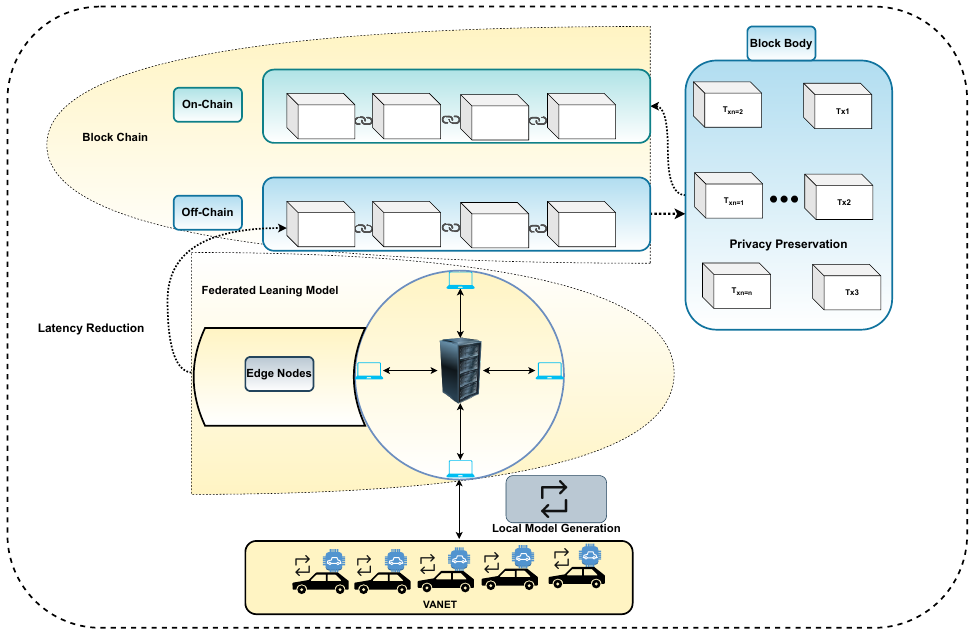
Figure 5. Integration of FL and blockchain in the VANET